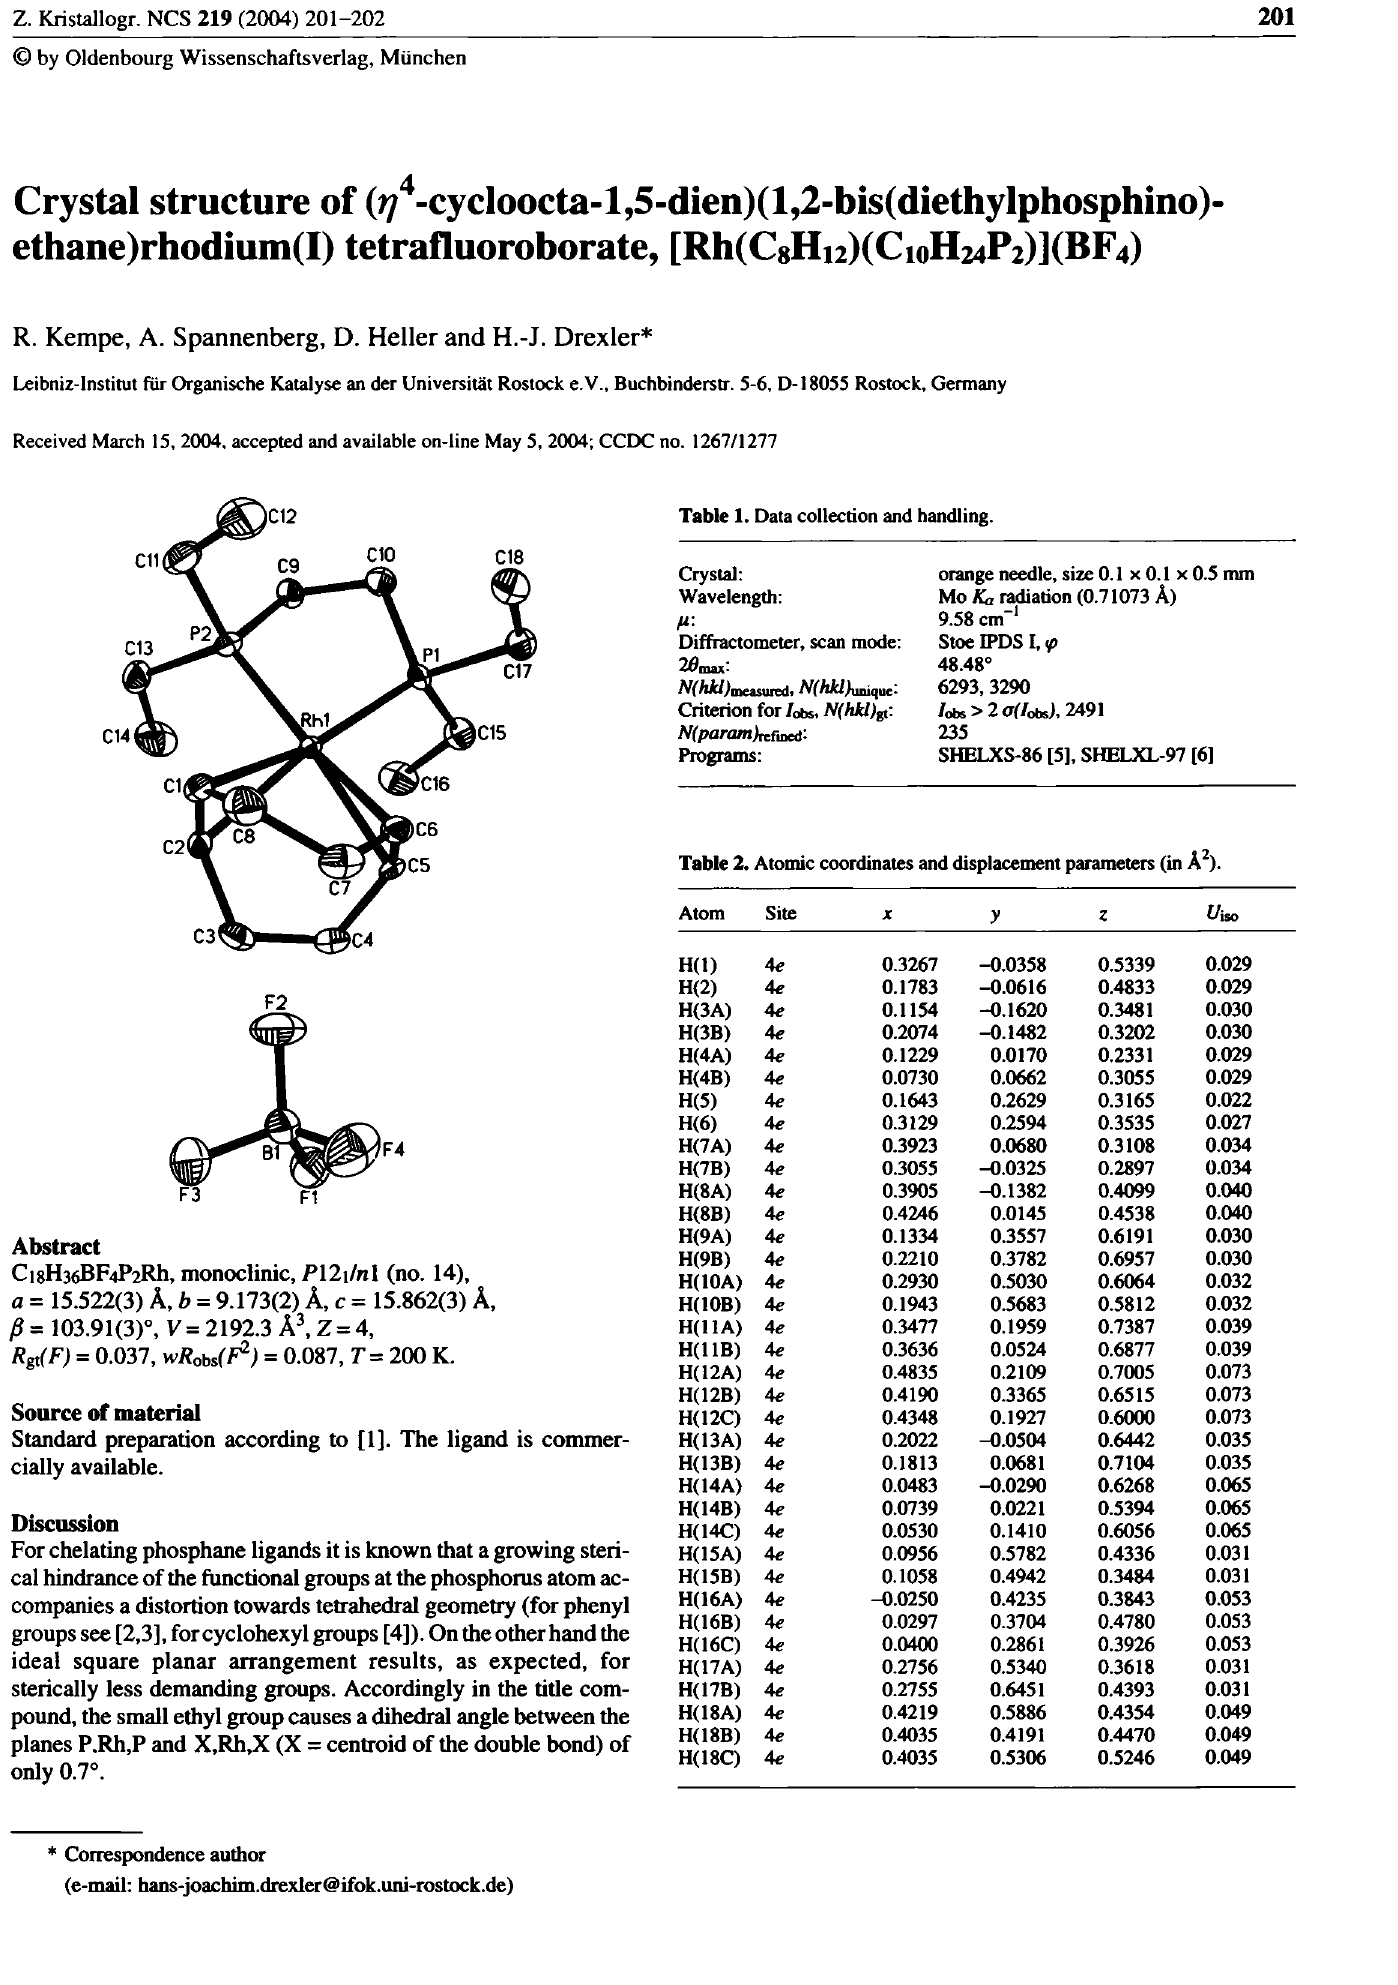
Table 1. Data collection and handling.